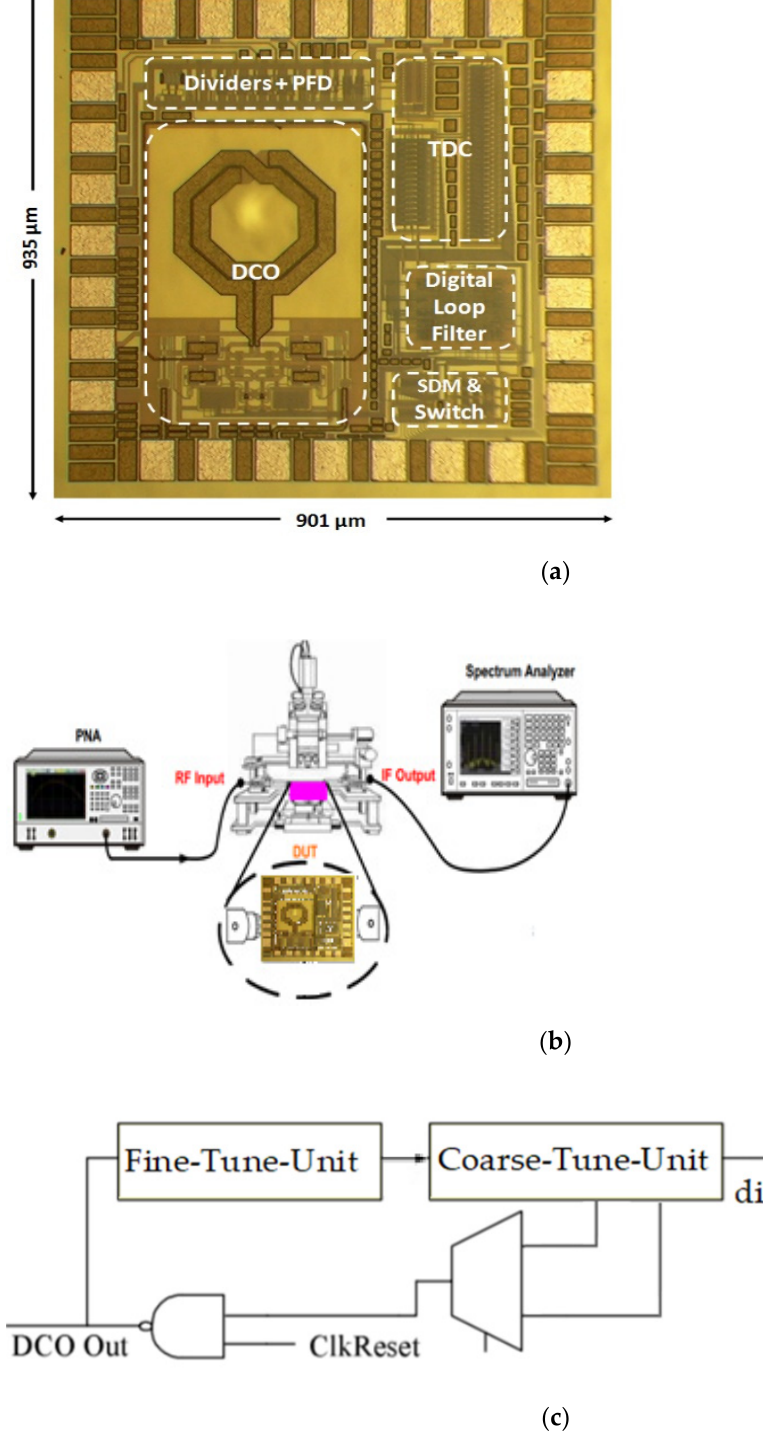
Figure 8. ( a ) The Die micrograph of the proposed frequency synthesizer with layout and placement square of 0.842 mm 2 . ( b ) Experimental conditions. ( c ) TDC placement drawing.